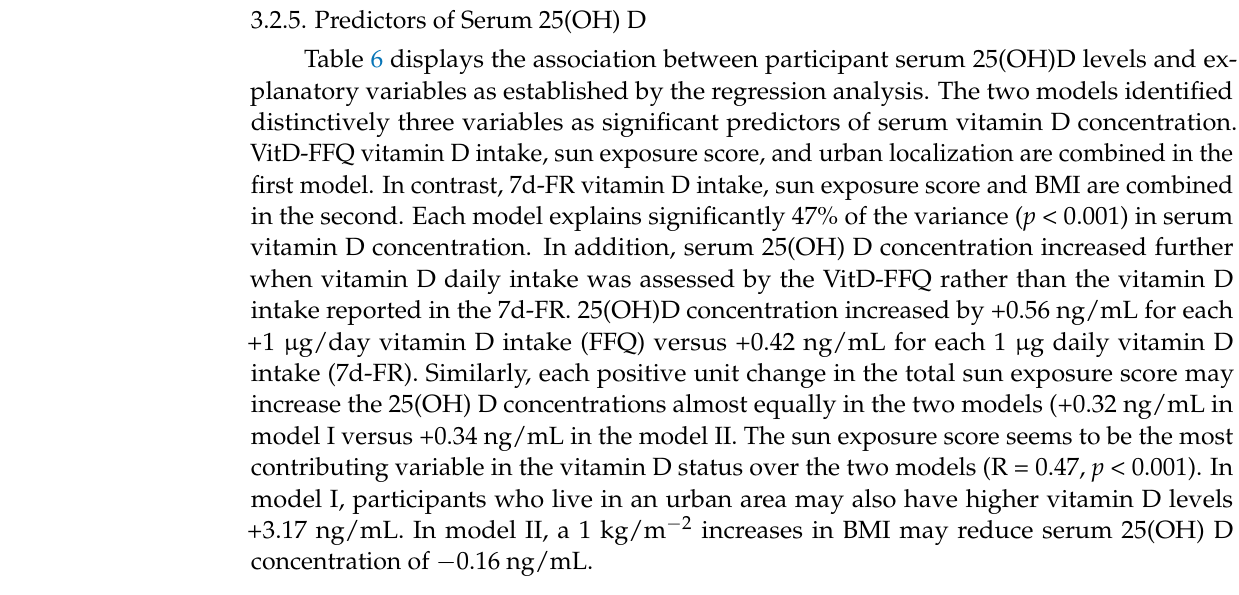
Table 6. Significant predictors of Serum 25(OH)D concentrations in study